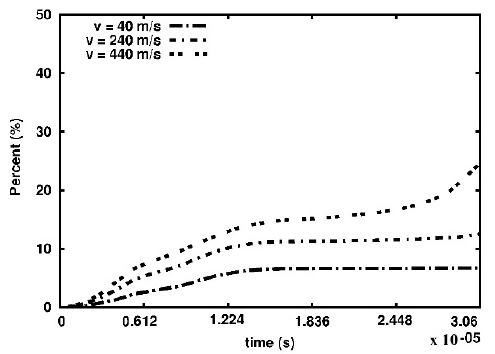
Figure 9. Percent of the damaged volume of the sample in time.